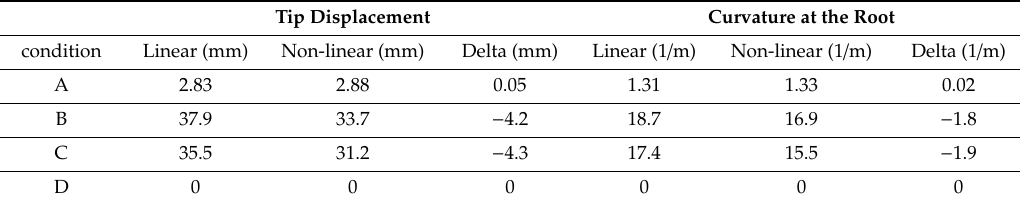
Table 2. Linear vs. nonlinear results.